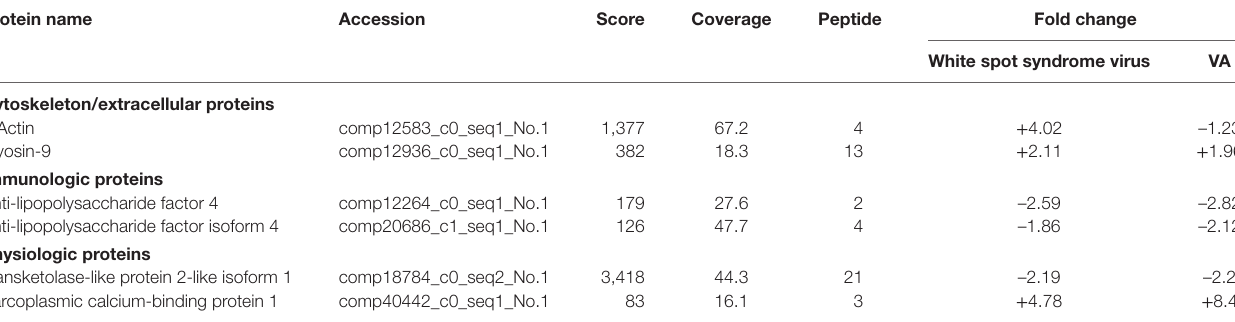
TaBle 3 | The selected proteins in Scylla paramamosain hemocytes with over two-fold change post infection. Protein